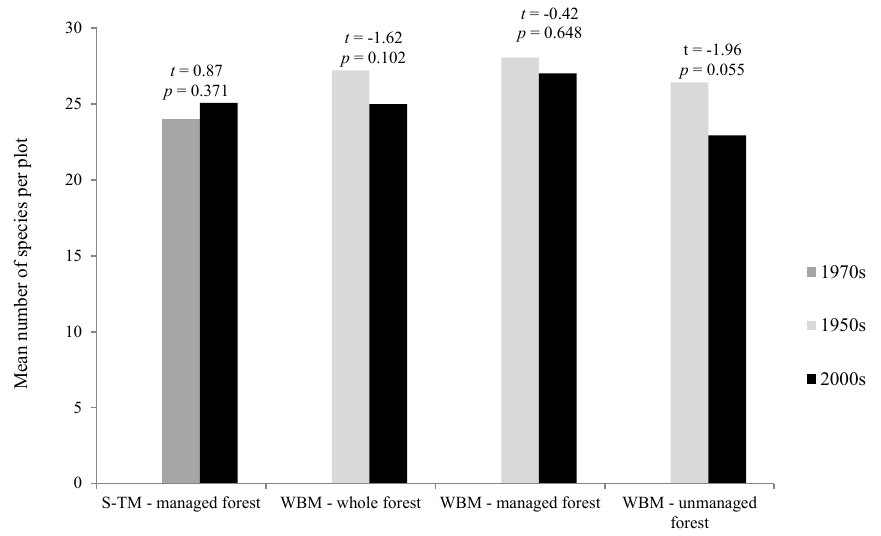
Figure 1. Changes in species richness in the Sanocko-Turczanskie Mountains and the Western Bieszczady Mountains. S-TM-managed forest: n = 66; WBM-whole forest: n = 62; WBM-managed forest: n = 30; WBM-unmanaged forest: n = 32 (paired t-test with bootstrap procedure ( n = 10,000)).